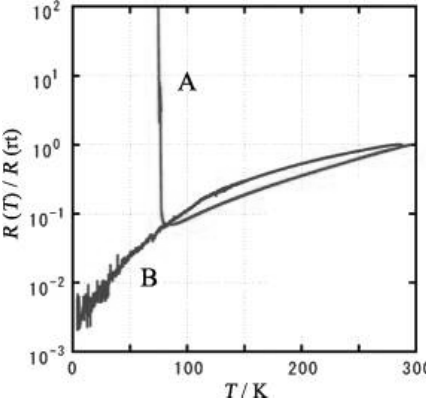
Figure 24. Temperature dependence of the normalized resistivities for (A) ( TMTSF )